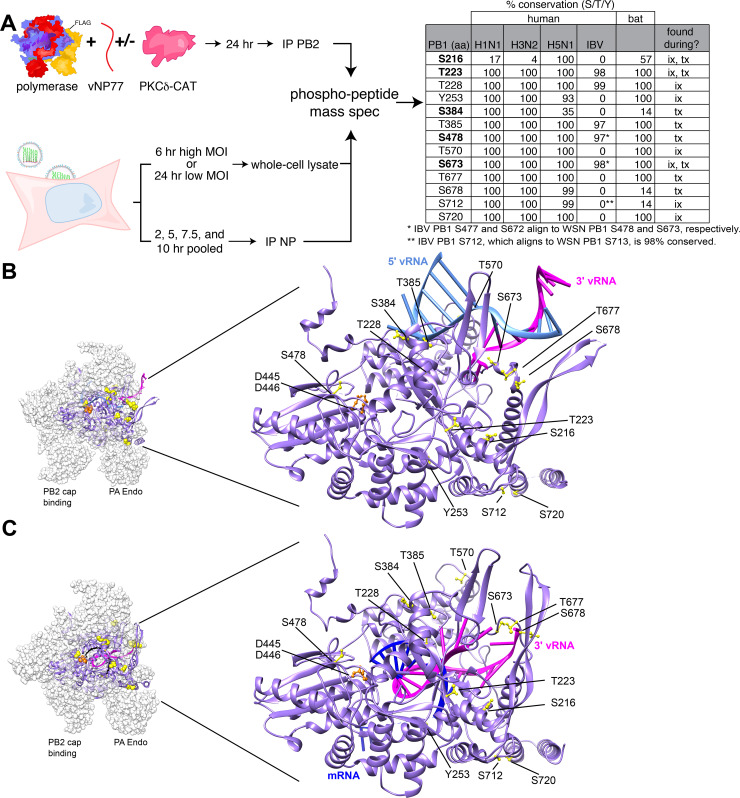
The catalytic core of the viral polymerase is phosphorylated during infection.A. Experimental design to detect phosphorylation of an active polymerase in transfected 293T cells or infected A549 cells. Samples were prepared as whole-cell lysate or immuno-purified proteins prior to phospho-peptide mass spectrometry. Most phospho-sites are conserved among circulating human influenza virus strains and highly pathogenic H5N1 viruses. PB1 sequences were aligned to WSN and the percentage where the indicated residue is a serine, threonine, or tyrosine is shown. Note that influenza B virus (IBV) residue numbering shifts relative to WSN. Whether phosphosites were detected during infection (ix), transfection (tx), or both is indicated. See S1 Table for all identified sites. B-C. Phospho-sites on PB1 surround the catalytic core and template entry. The location of PB1 phospho-sites characterized in this study are modeled in yellow on (B) a pre-initiation complex (PDB 4WSB [44]) or (C) a transcriptional elongation complex (PDB 6T0V [36]). The motif C residues D445/D446 in the catalytic site are in orange, 5’ vRNA is light blue, 3’ vRNA is magenta, and transcription product is dark blue. Residue assignment and numbering based on WSN. PA and PB2 are shown as white in the space-fill representation, but are not shown in the close-up structure to increase clarity. Similarly, the 5’ hook vRNA is not shown in C. See additional structures in S3 Fig.